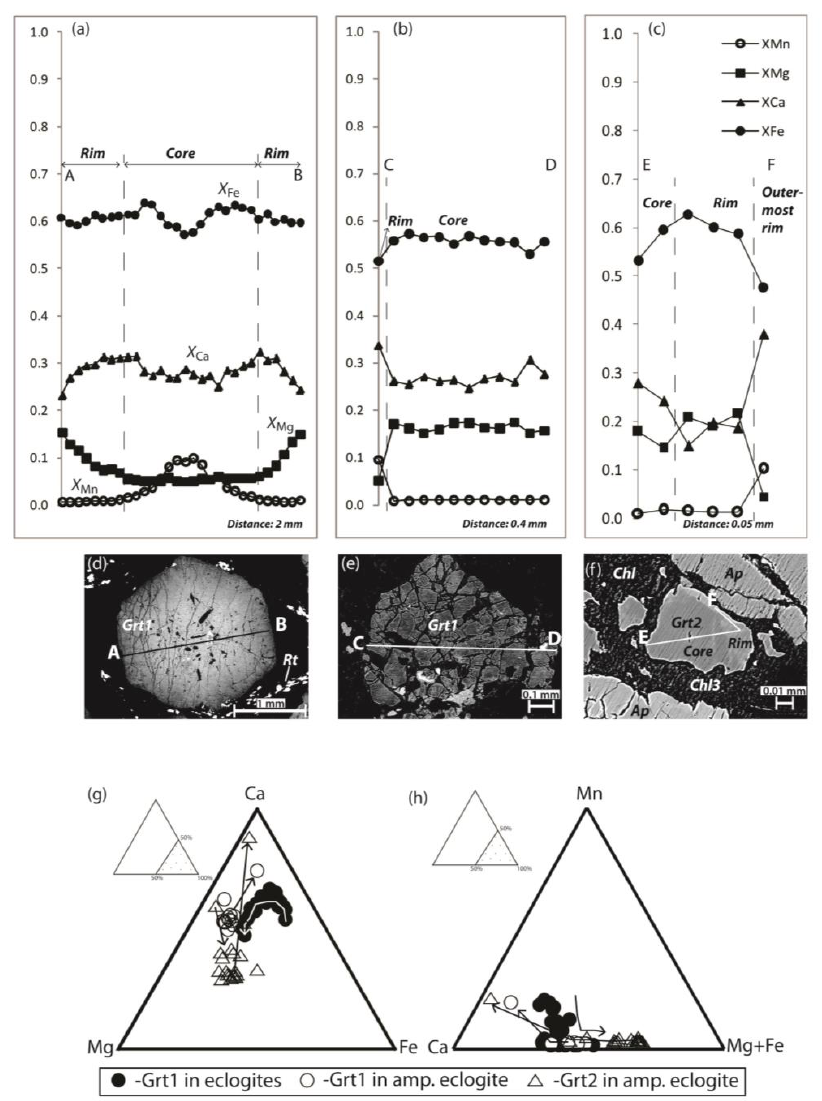
Figure 6. zoning patterns of garnets. Zoning patterns (rim-rim) of Grt1 from eclogites ( a ), amphibolitized eclogite ( b ), and zoning pattern of Grt2 ( c ) shown. ( d ) A,B analysis line on the Grt1 of eclogite. Result of analysis is shown in Figure6a. ( e ) C,D analysis line on the garnet of amphibolitized eclogite. Result of analysis is shown in Figure6b. Garnet (Grt1) from the amphibolitized eclogites is mainly homogeneous in composition except in outermost rim with high Mn content. ( f ) E,F analysis line on the garnet (Grt2) of amphibolitized eclogites. Result of analysis is shown in Figure6c; ( g ) Ca−Mg−Fe chemical diagram for garnets of eclogites and amphibolitized eclogites. White arrow indicates from core to rim of garnet in the eclogite. Black arrow indicates from core to rim of Grt2 in the amphibolitized eclogites. ( h ) Mn−Ca−Mg + Fe chemical diagram for garnets of eclogites and amphibolitized eclogites. Arrows indicate from core to rim of garnet in the eclogites and amphibolitized eclogites.